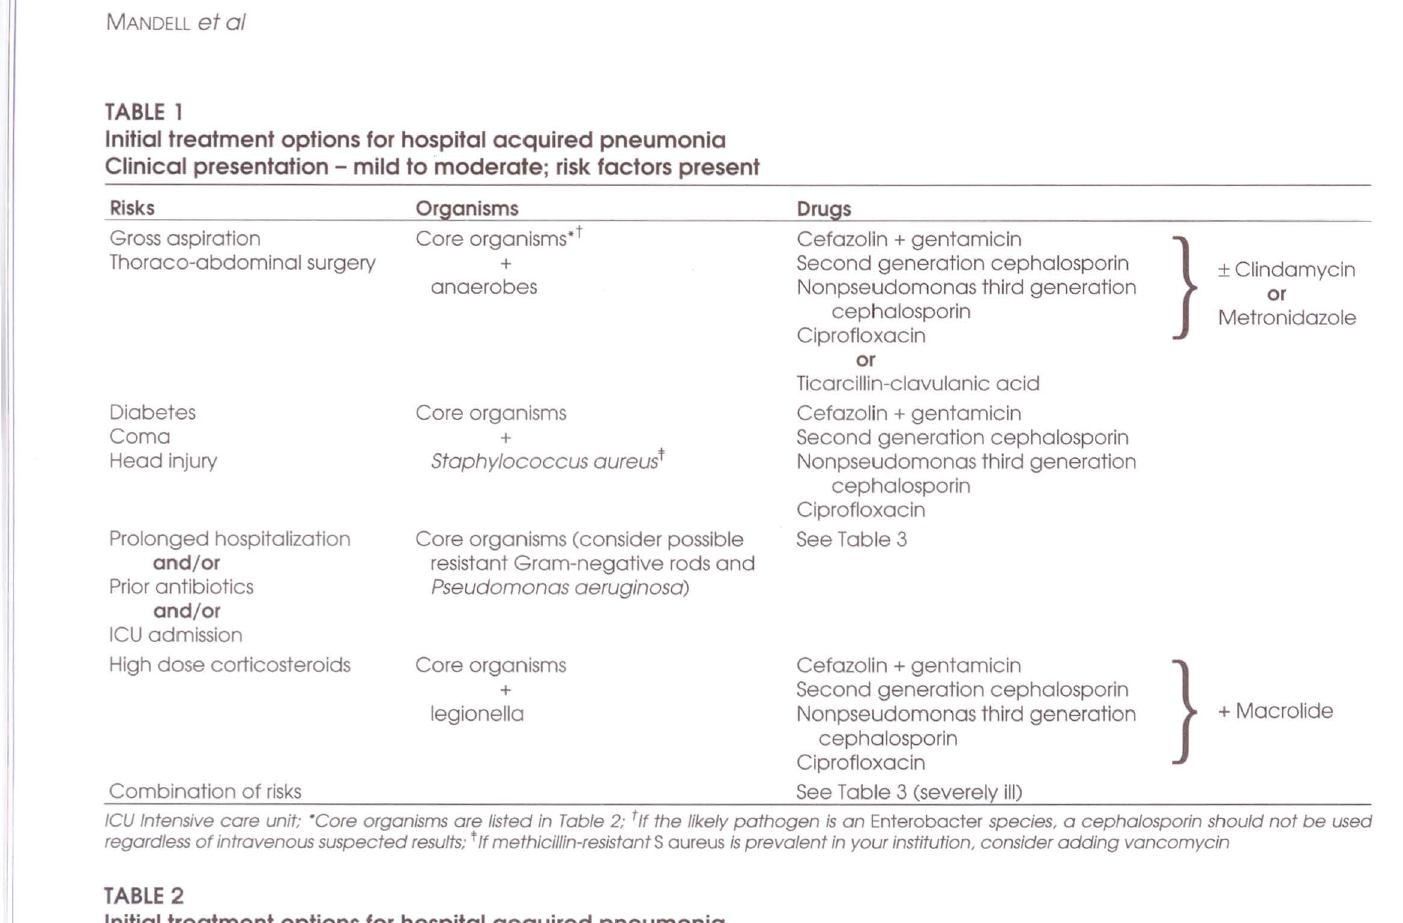
Initial treatment options for hospital acquired pneumonia Clinical presentation - mild to moderate; no unusual risk factors Organisms• Intravenous